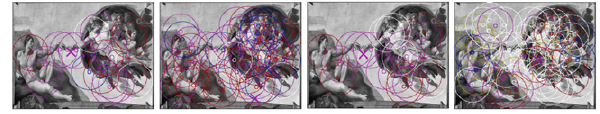
Figure 15: Examples of images that represent the different answers of four robots on a test image. These robots learned in the museum and we notice their different preferences by the colors of the circles representing the emotional category associated with local views.